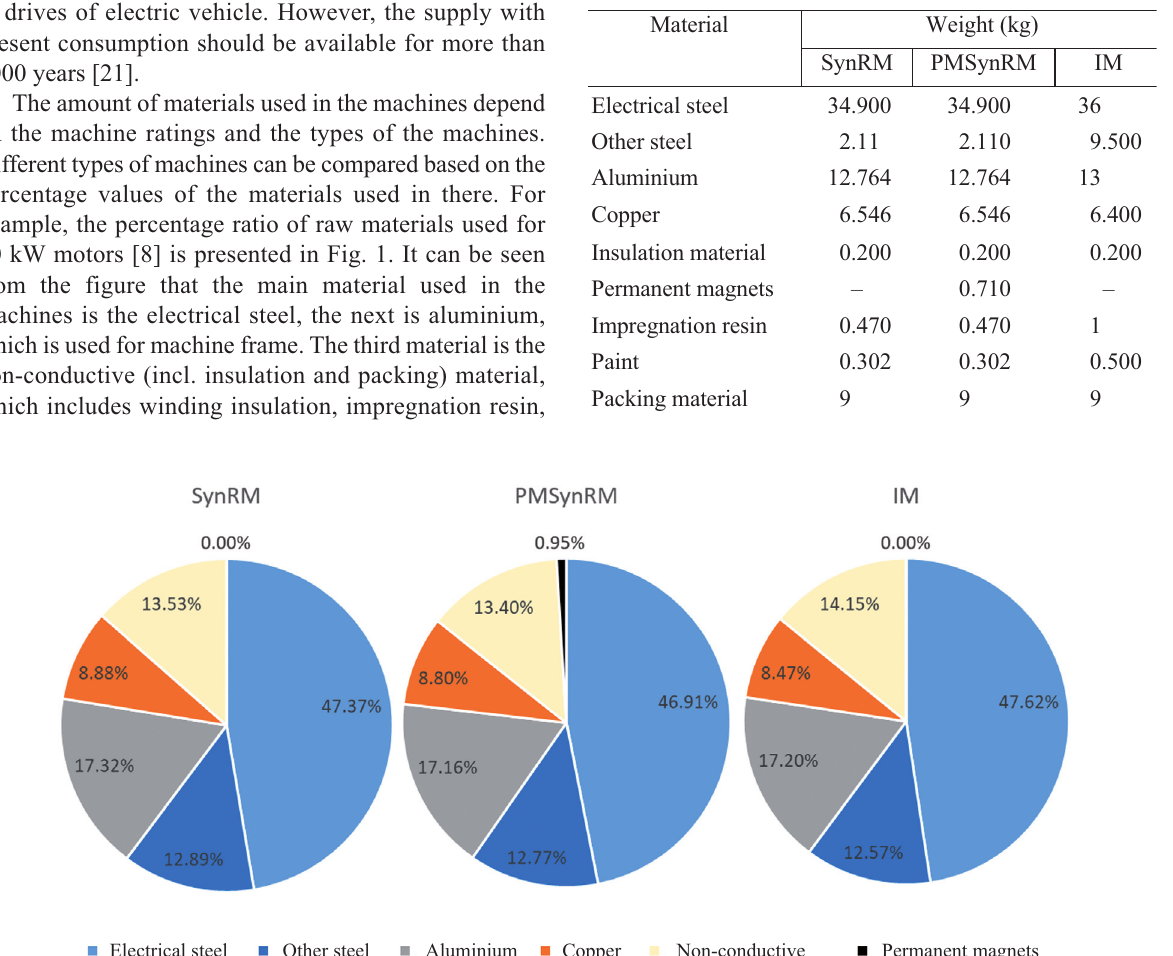
Table 1. Bill of materials for motor